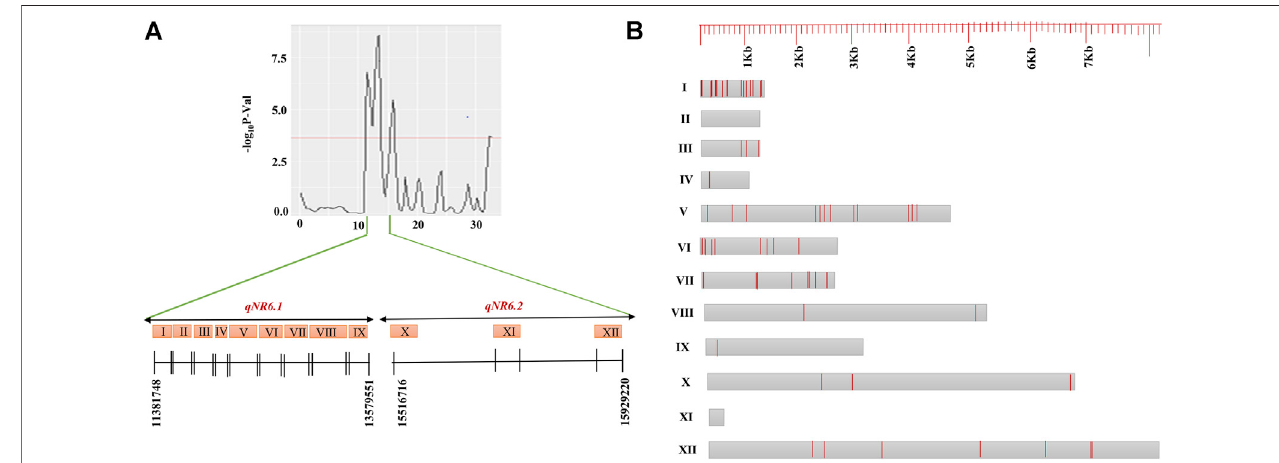
( Table 6 ). Comparison of amino acid sequences